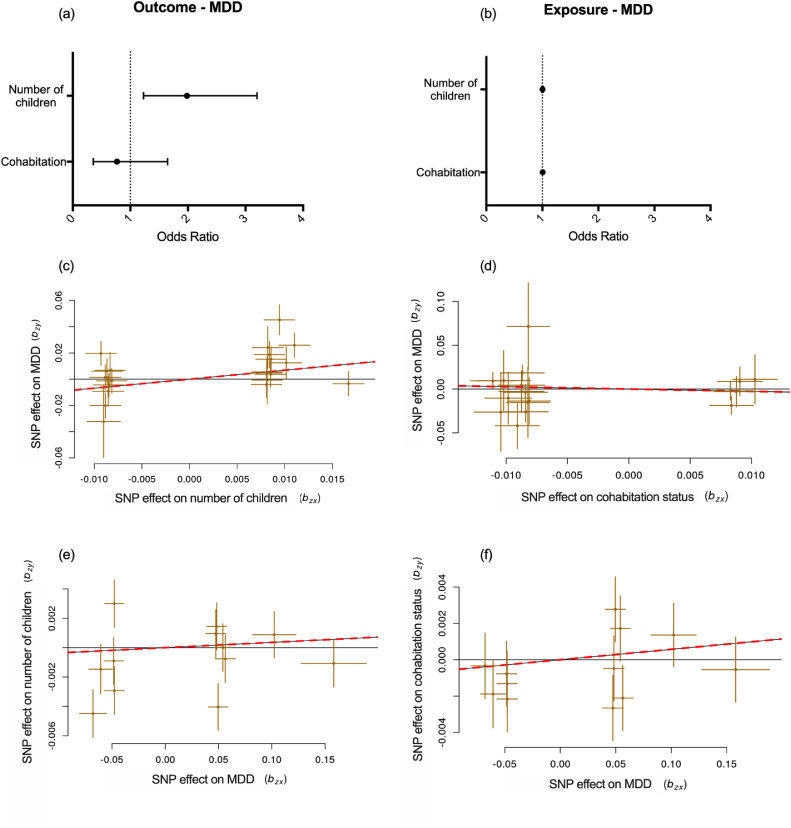
Mendelian randomisation. MDD = major depressive disorder; SNP = single nucleotide polymorphism. Panel (a) shows the combined GSMR estimated effect sizes (odds ratio ± 95% confidence interval) of family status on lifetime depression. Panel (b) shows the combined GSMR estimated effect sizes of lifetime depression on family status. Panel (c) shows the scatterplot of SNP potential effects on number of children vs lifetime depression. Panel (d) shows the scatterplot of SNP potential effects on cohabitation status vs lifetime depression. Panel (e) shows the scatterplot of SNP potential effects on lifetime depression vs number of children. Panel (f) shows the scatterplot of SNP potential effects on lifetime depression vs cohabitation status. For panels (c) – (f), the slope of the line indicates the estimated MR effect. Data in these panels are expressed as raw β values with standard errors.